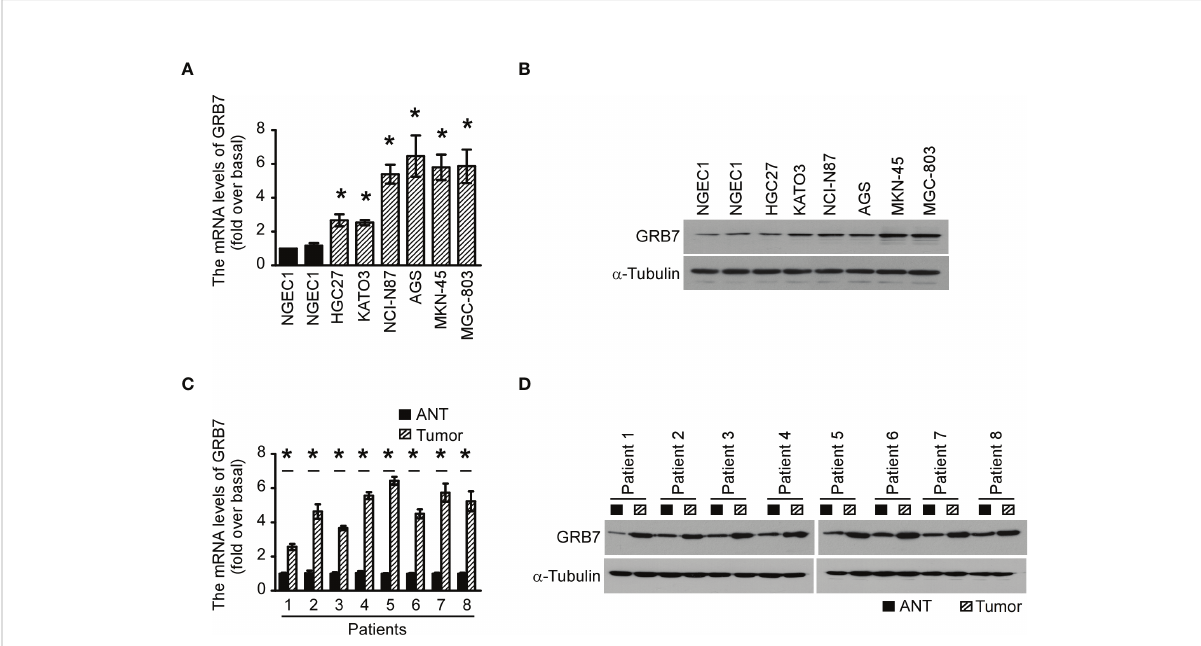
FIGURE 1 The expression of GRB7 in gastric cancer cells and gastric cancer tissues was up-regulated. (A) The qPCR results showed that GRB7 levels in the 6 human gastric cancer cell lines were signi fi cantly higher than the two normal gastric epithelial cells (NGEC1 and NGEC2). The statistics were compared with NGEC1. *P<0.05. (B) Western blot analysis showed that GRB7 protein levels were correspondingly increased in 6 human gastric cancer cells. (C) The GRB7 mRNA level in gastric tumor tissues of 8 patients was signi fi cantly higher than that of their paired adjacent tissues. (D) The amount of GRB7 protein in matched gastric cancer tissues was also higher than that in their respective paired adjacent tissues. The results of each tumor were statistically compared with the adjacent normal tissue data. *P<0.05. Gastric tumor tissue is abbreviated as tumor, and adjacent normal tissue is abbreviated as